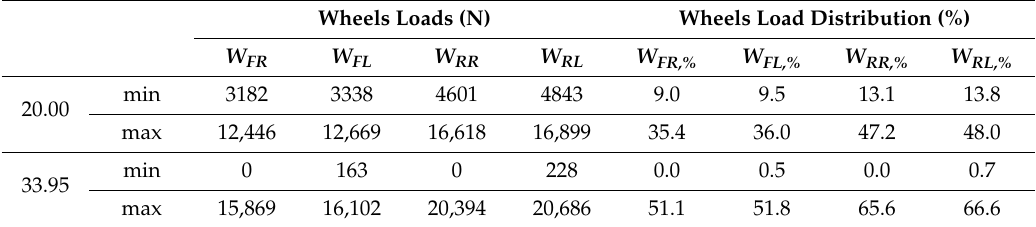
Table 7. Maximum and minimum values recorded during a complete rotation of the turntable for α = 20.00 ◦ and α = 33.95 ◦ (incipient